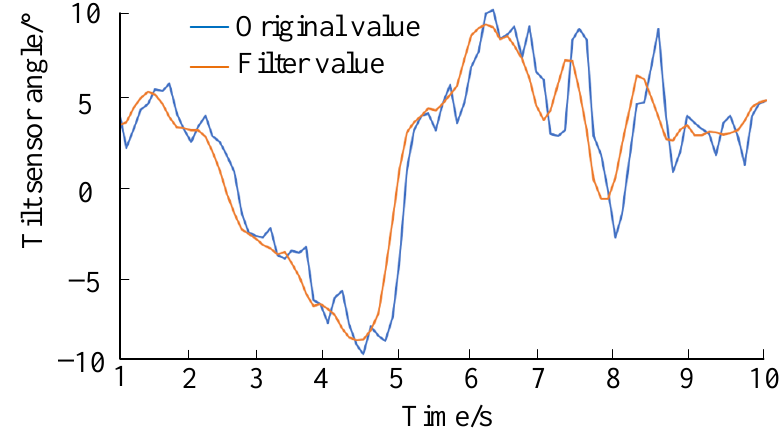
Figure 5. Comparison of sensor filtering effect.